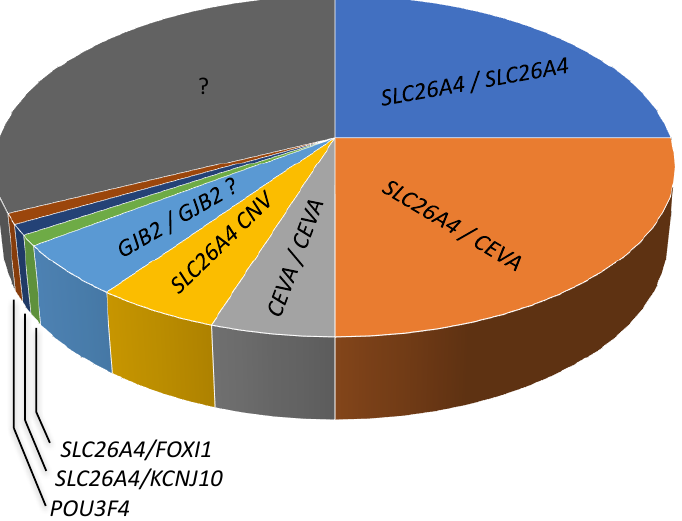
Figure 4. Approximate proportion of genetic determinants (first allele/second allele) of hearing loss and EVA in Caucasian cohorts. CEVA, Caucasian enlarged vestibular aqueduct haplotype; CNV, copy number variation; ? indicates a controversial finding or undetermined